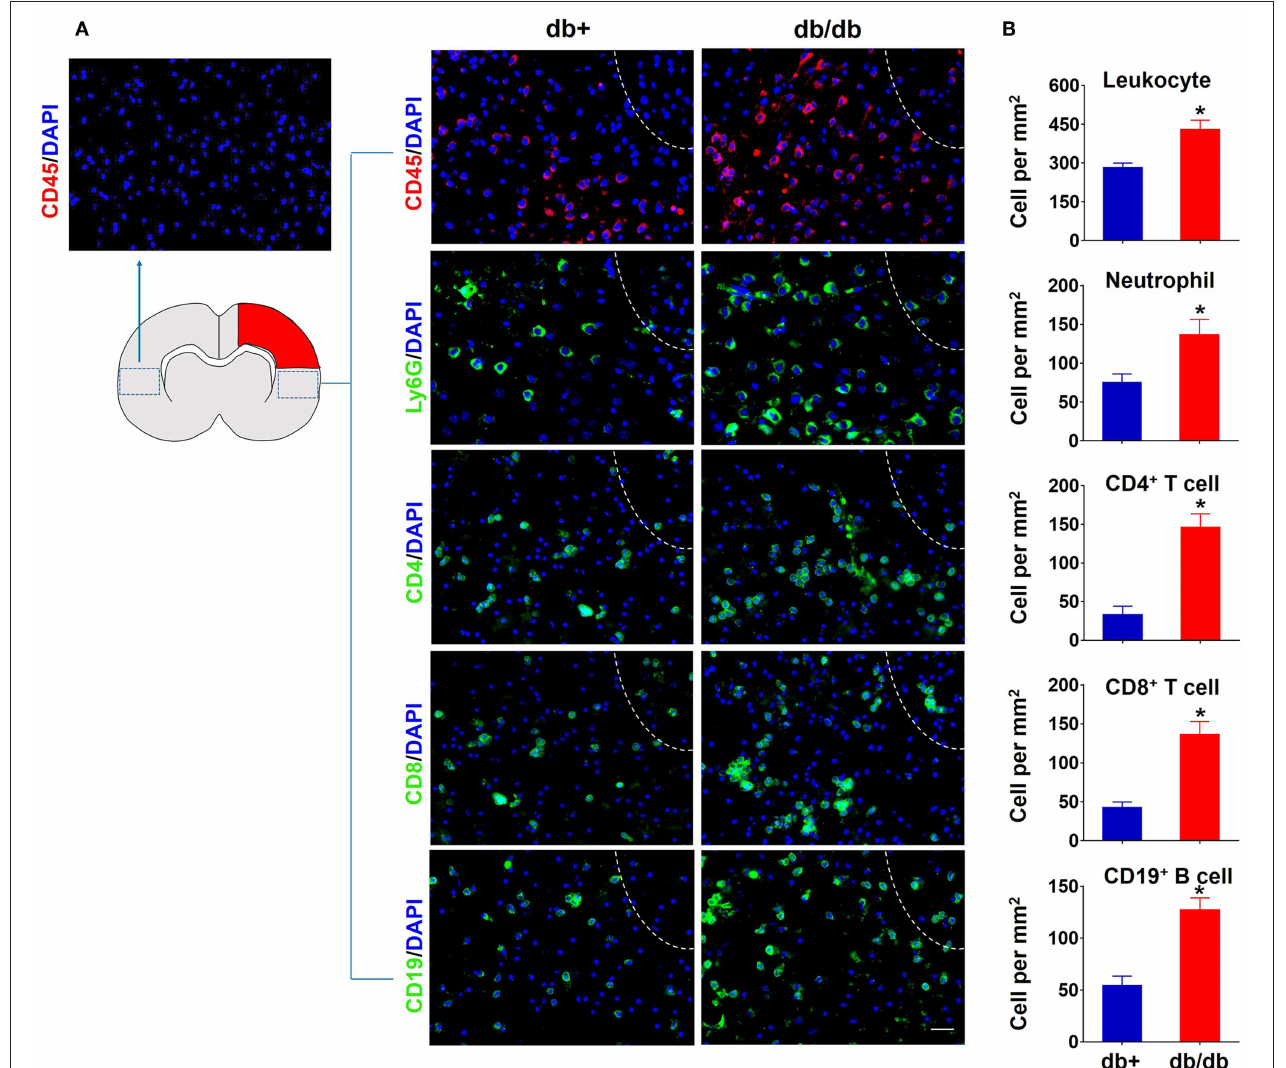
FIGURE 2 | Accumulation of brain-infiltrating leukocyte subsets in the ischemic brain of db/db mice subjected to dMCAO assessed by immune staining. (A) At 7 days after dMCAO, increased counts of CD45 + leucocytes, CD4 + T, CD8 + T, CD19 + B cells, and Ly-6G + neutrophils were seen in the peri-infarct region of brain sections from db/db mice vs. db/ + controls. The right side of white lines represents infarct area. Scale bars: 50 µ m. (B) Quantification of brain-infiltrating immune cell subsets in db/ + and db/db mice subjected to dMCAO at day 7 after ischemia. Data are expressed as mean ± s.e.m. * p < 0.05: db/ + vs. db/db, n = 8 per group.